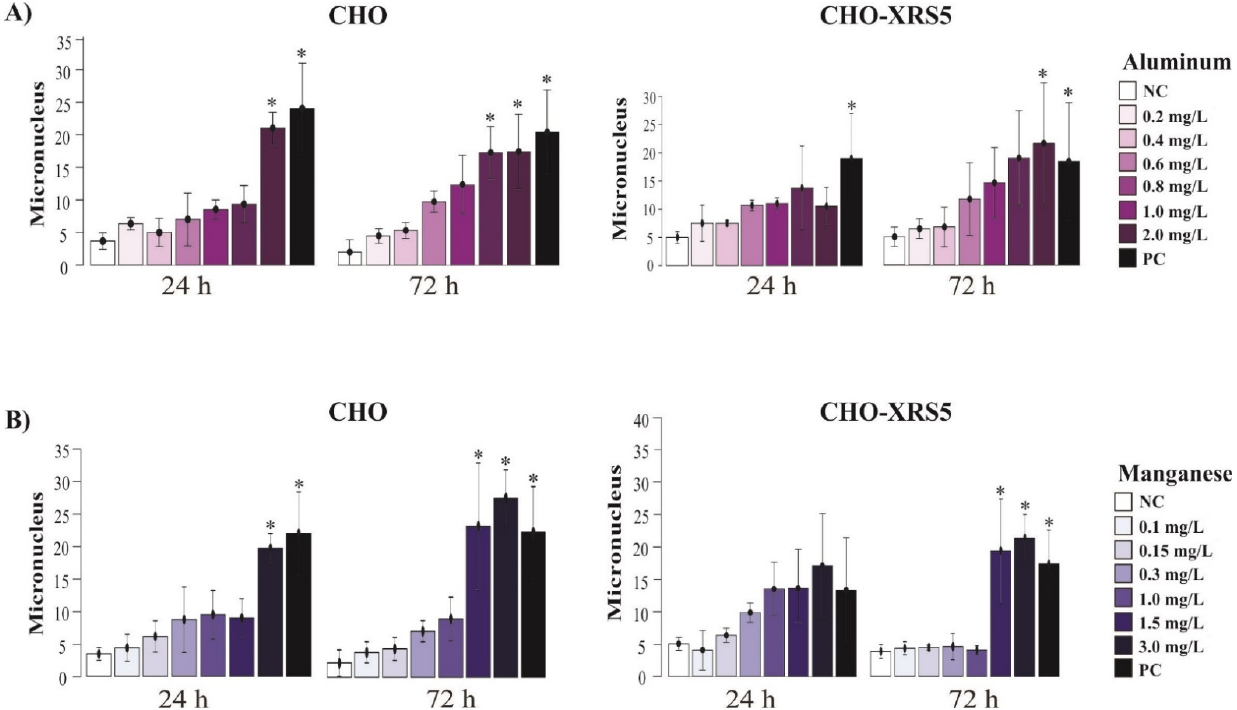
Figure 3. Effect of aluminum ( A ) and manganese ( B ) on micronucleus formation in binucleated Chinese hamster ovary (CHO) and CHO-XRS5 cells after 24 and 72 h of incubation. Data are expressed as means ± standard deviation of two independent experiments. * p < 0.05 compared to the negative control via analysis of variance followed by Tukey’s test. NC, negative control; PC, positive control.